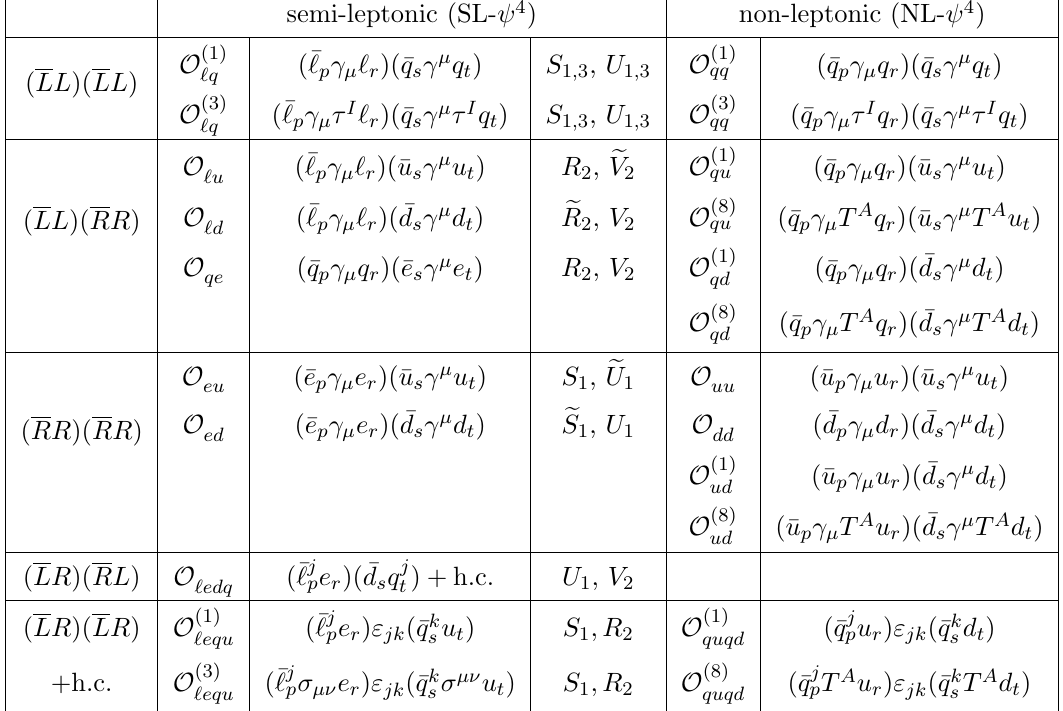
Table 1. Semi- and non-leptonic 4 operators in SMEFT. Chirality indices have been omitted on SU(2) L doublet (cid:12)elds q L , ‘ L and singlet (cid:12)elds u R , d R , e R , respectively. The (cid:28) I denote the Pauli matrices and T A = (cid:21) A = 2 the SU(3) c color generators where (cid:21) A are the Gell-Mann matrices. The third column for semi-leptonic operators indicates which LQ models contribute in the tree-level matching, see appendix B for